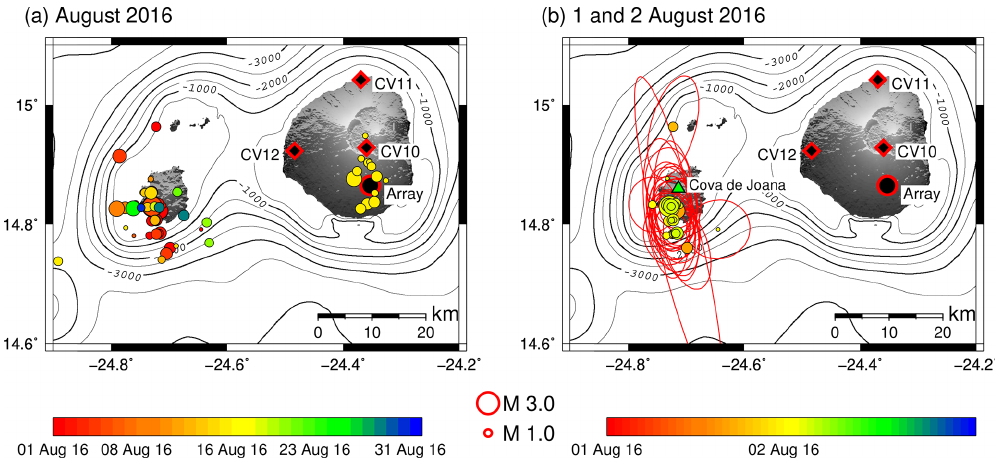
Figure 7. (a) Earthquake locations during August 2016, including the seismic crisis. Red/black circle: position of the array, red/black diamond: additional broadband stations on Fogo. (b) Earthquake locations during the seismic crisis on 1 and 2 August 2016. Red ellipses: errors in backazimuth and distance as determined for the array analysis. Red/black circle: position of the array, red/black diamond: additional broadband stations on Fogo. Green triangle: village Cova de Joana, evacuated during the seismic crisis. Topographic and bathymetry data are from Ryan et al. (2009).